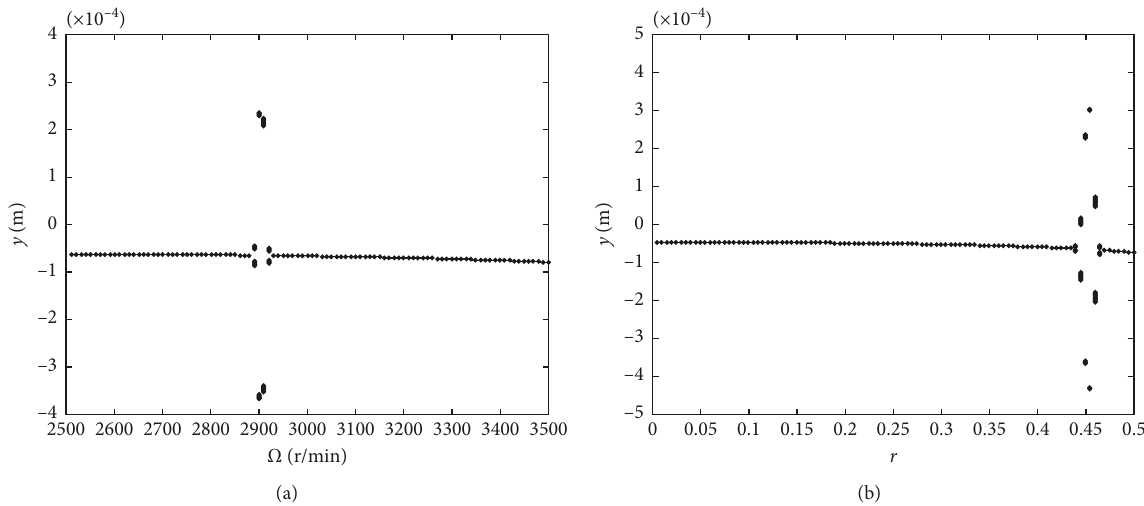
5 m, and ζ 1 10 (cid:31) × −